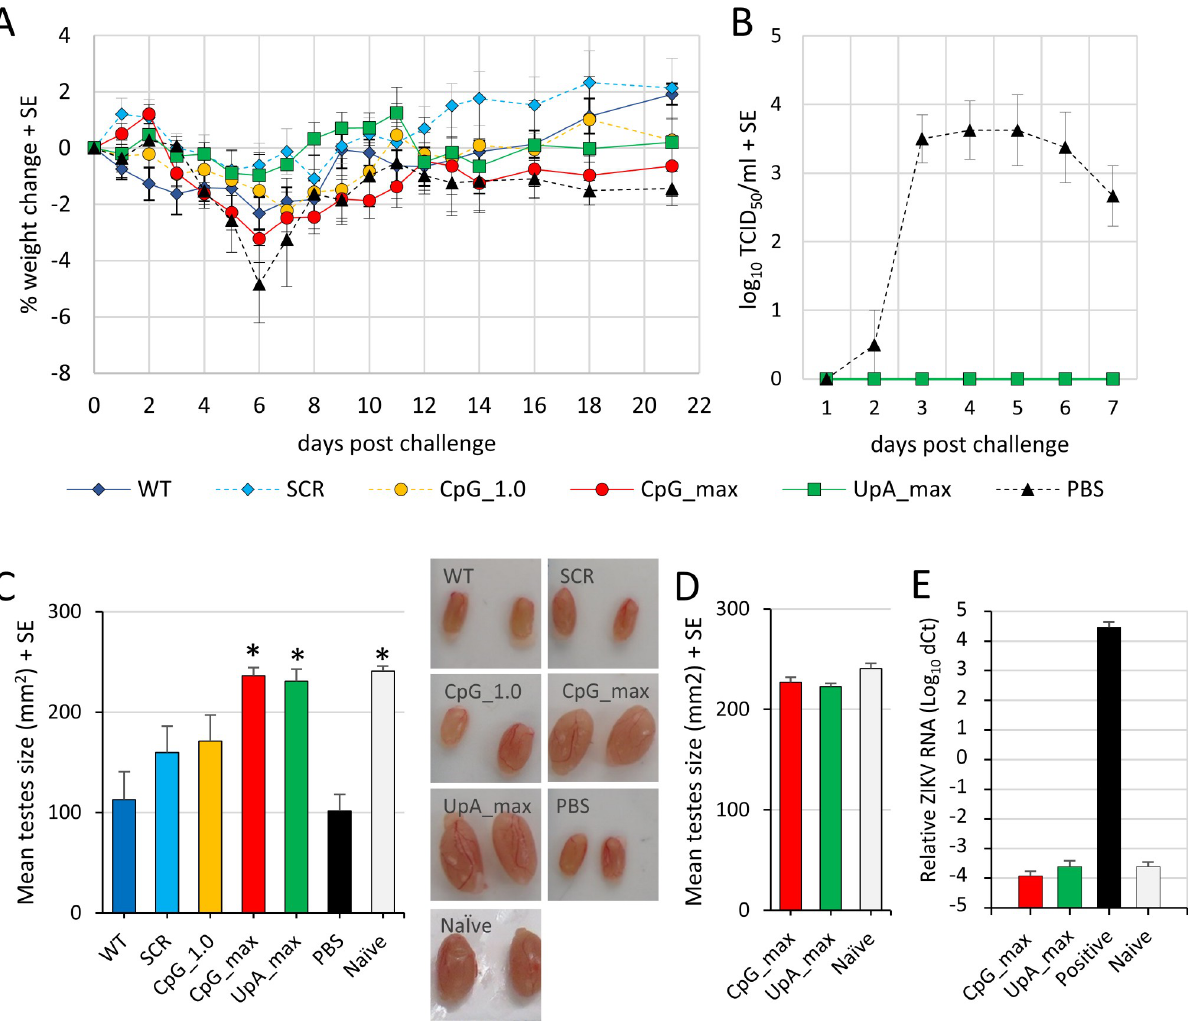
Fig 7. Weight loss, viremia, and testes size in IFNAR − / − mice post-ZIKV PRVABC59 challenge. (A) Weight loss of ZIKV PRVABC59 -challenged IFNAR − / − mice ( n = 3–5 mice per group). (B) Viremia post-ZIKV PRVABC59 challenge ( n = 4–5 mice per group). (C) Testes size (height × width) and representative images of testes from vaccinated mice post-ZIKV PRVABC59 challenge compared with testes of not vaccinated, PBS-injected control mice and na ï ve (uninfected, healthy control) mice. Asterisk indicates significant difference from mice that received PBS injections instead of vaccination prior to ZIKV PRVABC59 challenge (Kruskal–Wallis test, p < 0.05). (D) Vaccine safety test displays the mean testis size of mice infected with CpG_max or UpA_max mutant viruses ( n = 6 mice per group, testes harvested on day 49 postvaccination) compared with testes size of na ï ve mice ( n = 3) without subsequent challenge. (E) qRT-PCR of ZIKV RNA in testes of mice from D and mice infected with ZIKV PRVABC59 for 48 days as positive control. Bars represent the mean Ct values normalized for RPL13A housekeeping RNA. The numerical values for this figure are available in S1 Data. Ct, cycle threshold; qRT-PCR, real-time quantitative reverse transcription PCR; SCR, scrambled control virus; WT, wild-type; ZIKV, Zika virus.